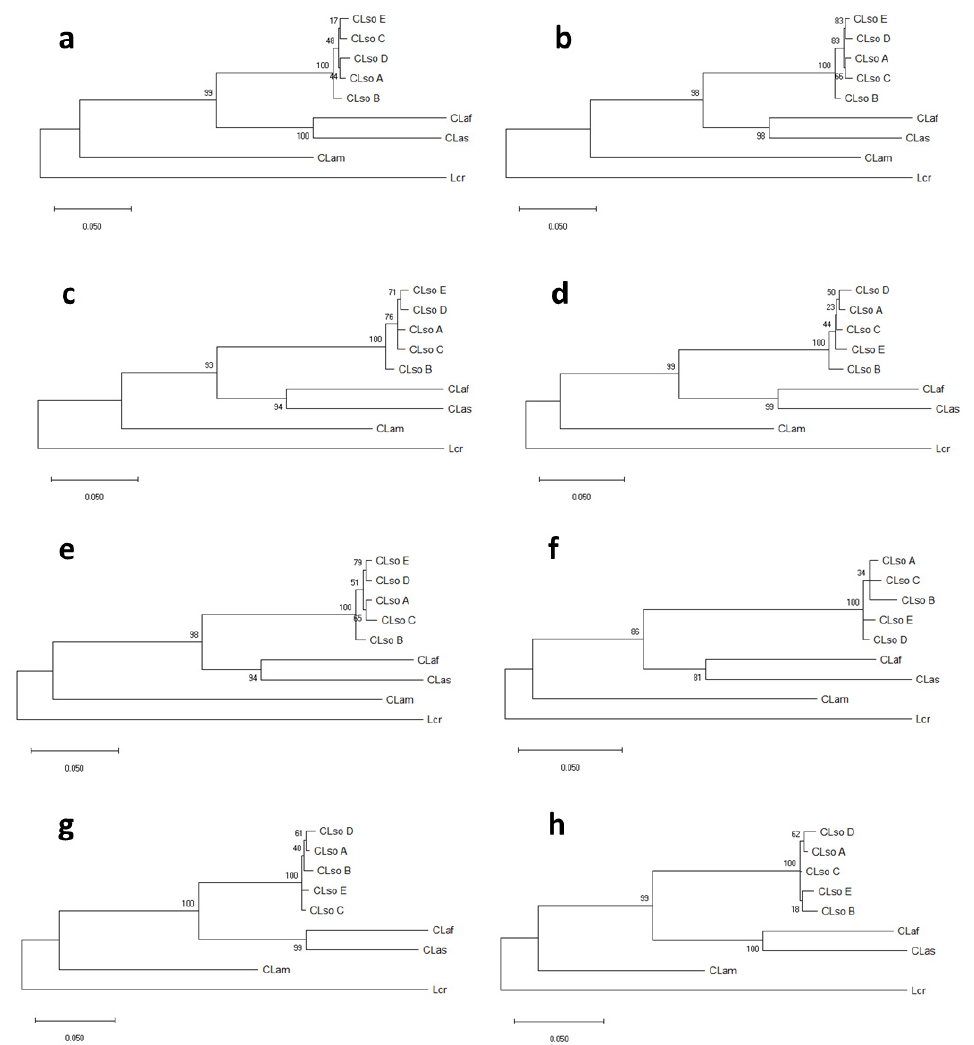
Figure 6. Phylogenetic trees of CLso, CLas, CLaf and Lcr based on concatenated sequences obtained from adk ‐ mutS ‐ icdA ( a ), adk ‐ dnaG ‐ icdA ( b ), adk ‐ dnaG ‐ recA ( c ) , adk ‐ mutS ‐ recA ( d ), adk ‐ icdA ( e ), adk ‐ recA